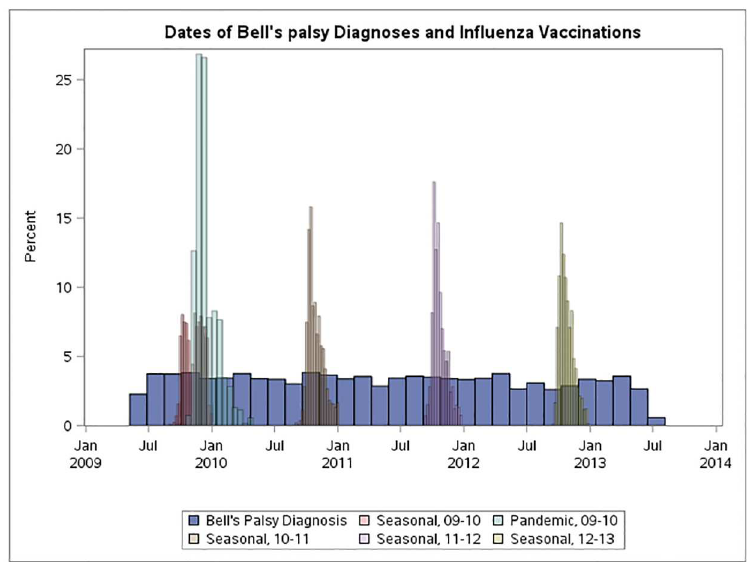
Fig 2. Distribution of acute respiratoryinfection dates and dates of vaccination during the observation period. There was no statistical evidenceof an associationbetweenBell’s palsy and